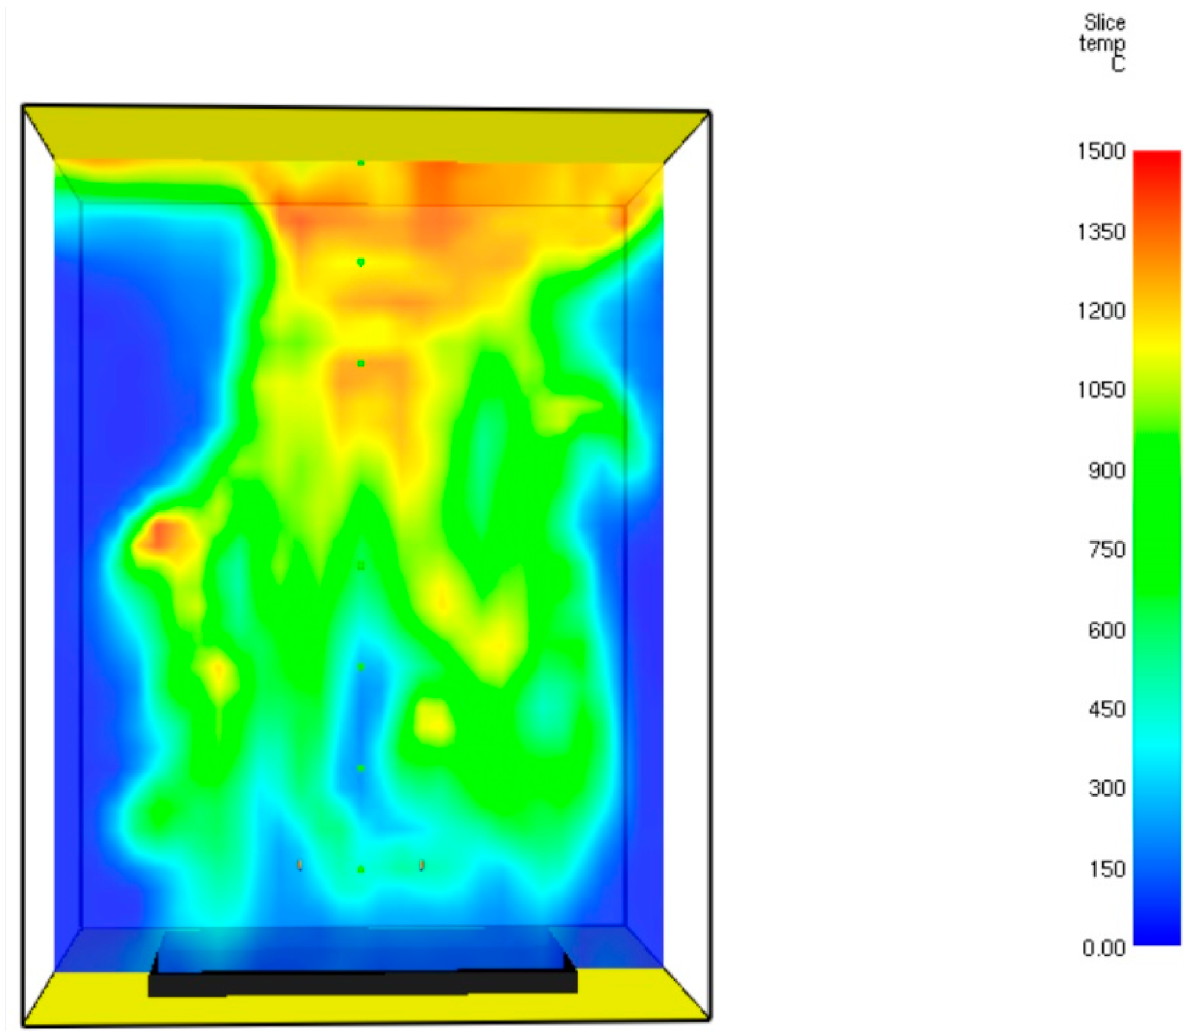
Figure 12. Temperature field ( ◦ C) of the flue gaseous mixture inside the burner at t = 60.7 s. It can be seen from this figure that the maximal temperature at time = 60.7 s reaches 1440 ◦ C. A similar value was reported in [18]. The temperature of the gaseous mixture tends to increase at the top of the burner. The calculated temperature at the bottom region of the burner is close to 700 ◦ C. A similar temperature was reported in Ahmed and Ateya [29]. The velocity field of the gaseous mixture at time of t = 60.7 s is presented in Figure